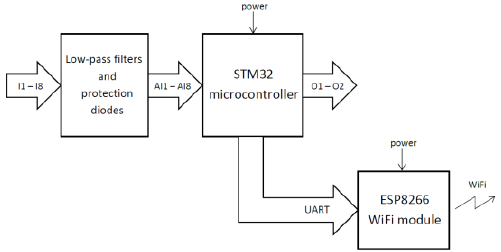
Fig. 1. Block diagram of the presented measurement card: I – Input, O – Output, AI – Analog Input